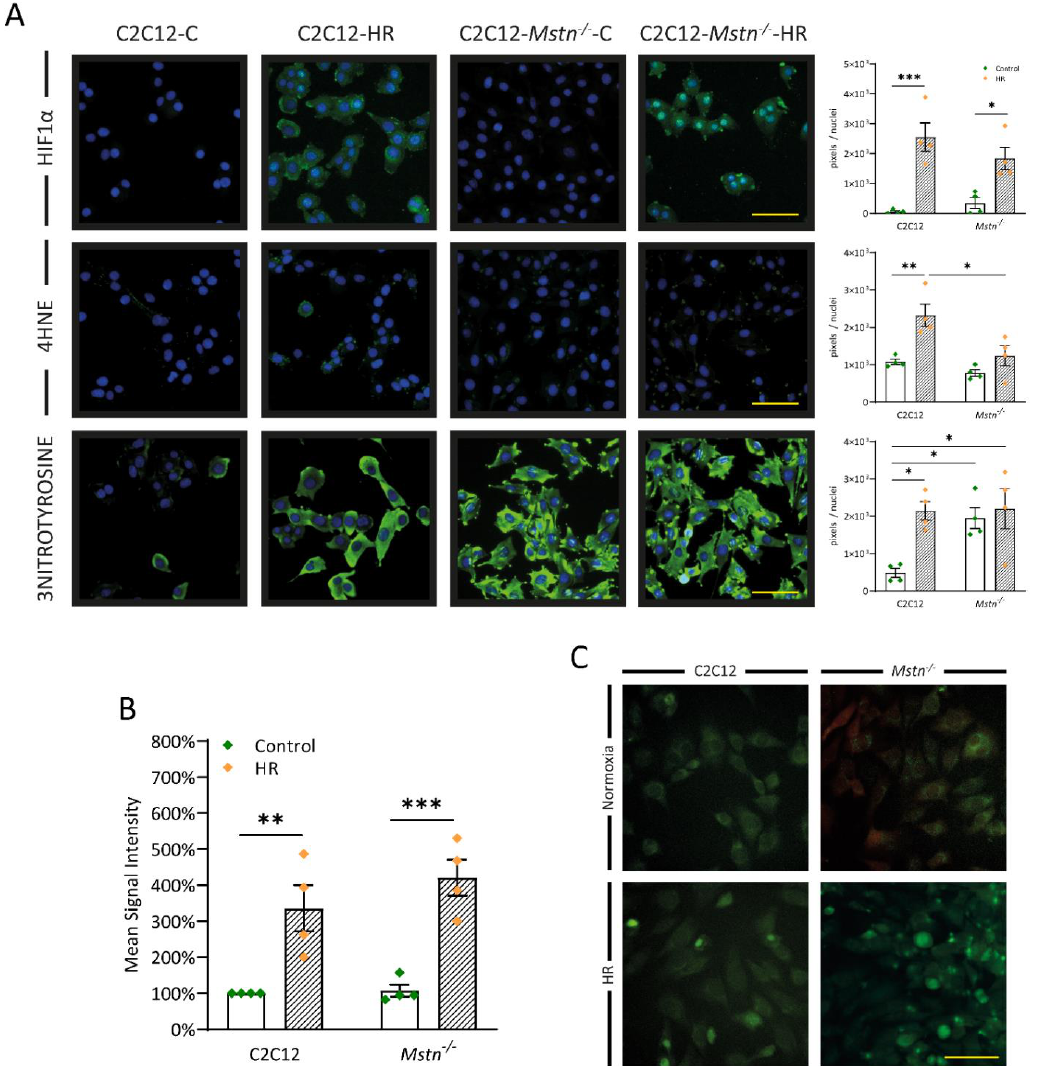
Figure 5. Rise of 3-Nitrotyrosine and 4-Hydroxynonenal (4HNE) levels due to HR in C2C12 cells accompanied by equal levels of ROS before and after HR in C2C12 and C2C12- Mstn −/− cells. ( A ) Immunofluorescence analysis of markers of hypoxia (HIF-1α), early lipid peroxidation (4-HNE), and nitrosative stress (3-Nitrotyrosine). Cell nuclei were counterstained with DAPI. ( B ) ROS formation in C2C12 and C2C12- Mstn −/− cells visualized and quantified using CellROX green reagent (Thermo Fisher Scientific, Massachusetts, USA). ( C ) Representative images of ROS visualization under normoxic (upper panel) and HR (lower panel) conditions. C, control cells incubated under normoxia. HR, cells incubated under hypoxic conditions for 4 h followed by normoxia for 15 min. For each graph, four independent experiments per group were conducted. Scale bar = 50 µm. Results are shown as means ± SEM. p -value: * < 0.05, ** < 0.01, *** < 0.001; ANOVA followed by a multiple test comparison via Tukey’s post-hoc test (homoscedasticity) or Brown–Forsythe and Welch ANOVA followed by Dunnett’s T3 post-hoc test (heteroscedasticity).